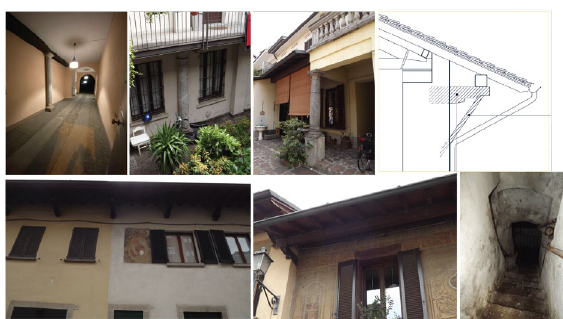
Figure 6. Photographic survey and technical drawings of found “traces of the past” in the historical centres. Source: Authors